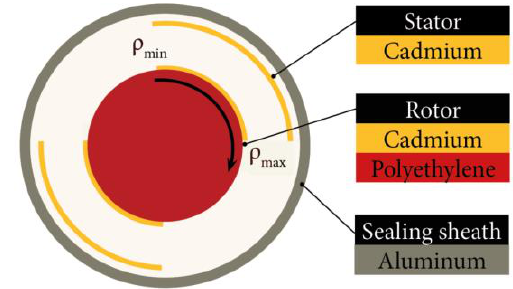
Figure 4. Main components of the neutronic design of